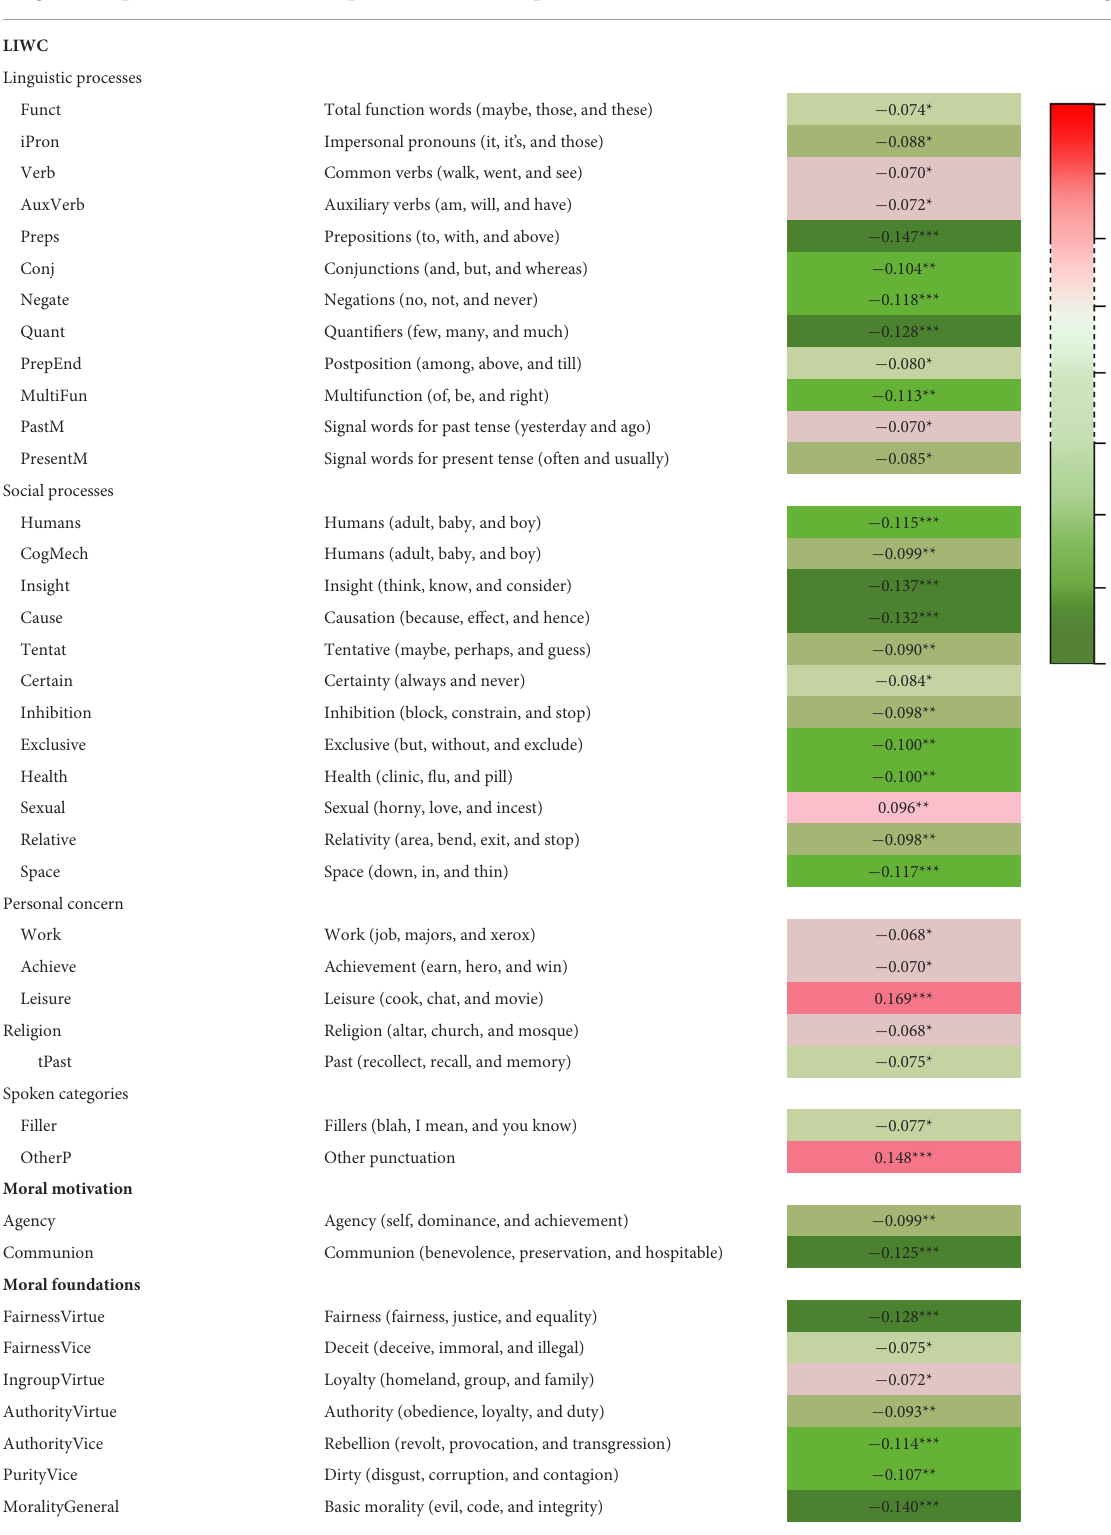
TABLE 2 Pearson correlation coefficients between important behavioral features and interaction anxiousness. Linguistic expression feature Explanation and example Interaction anxiousness Meaning of